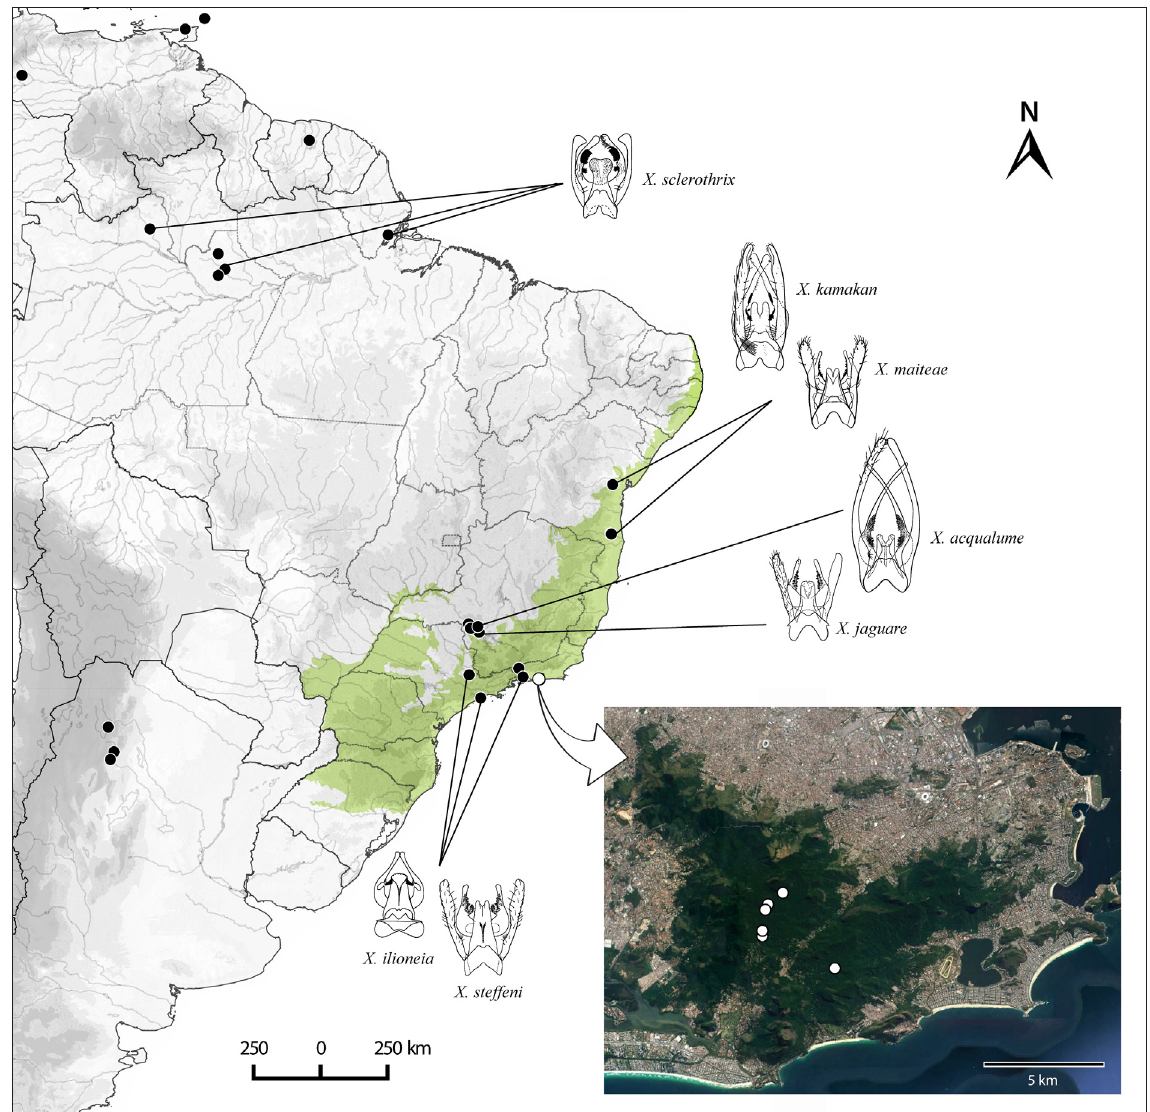
Fig. 1. Map showing the collecting sites at Parque Nacional da Tijuca (white circles) and distribution of Xiphocentron Brauer, 1870 in Brazil and part of South America (black circles). Species occurring in Brazil are figured in dorsal view (modified from Schmid 1982; Pes et al. 2013; Vilarino & Calor 2015; Rocha et al. 2017). The Atlantic Forest biome is highlighted in